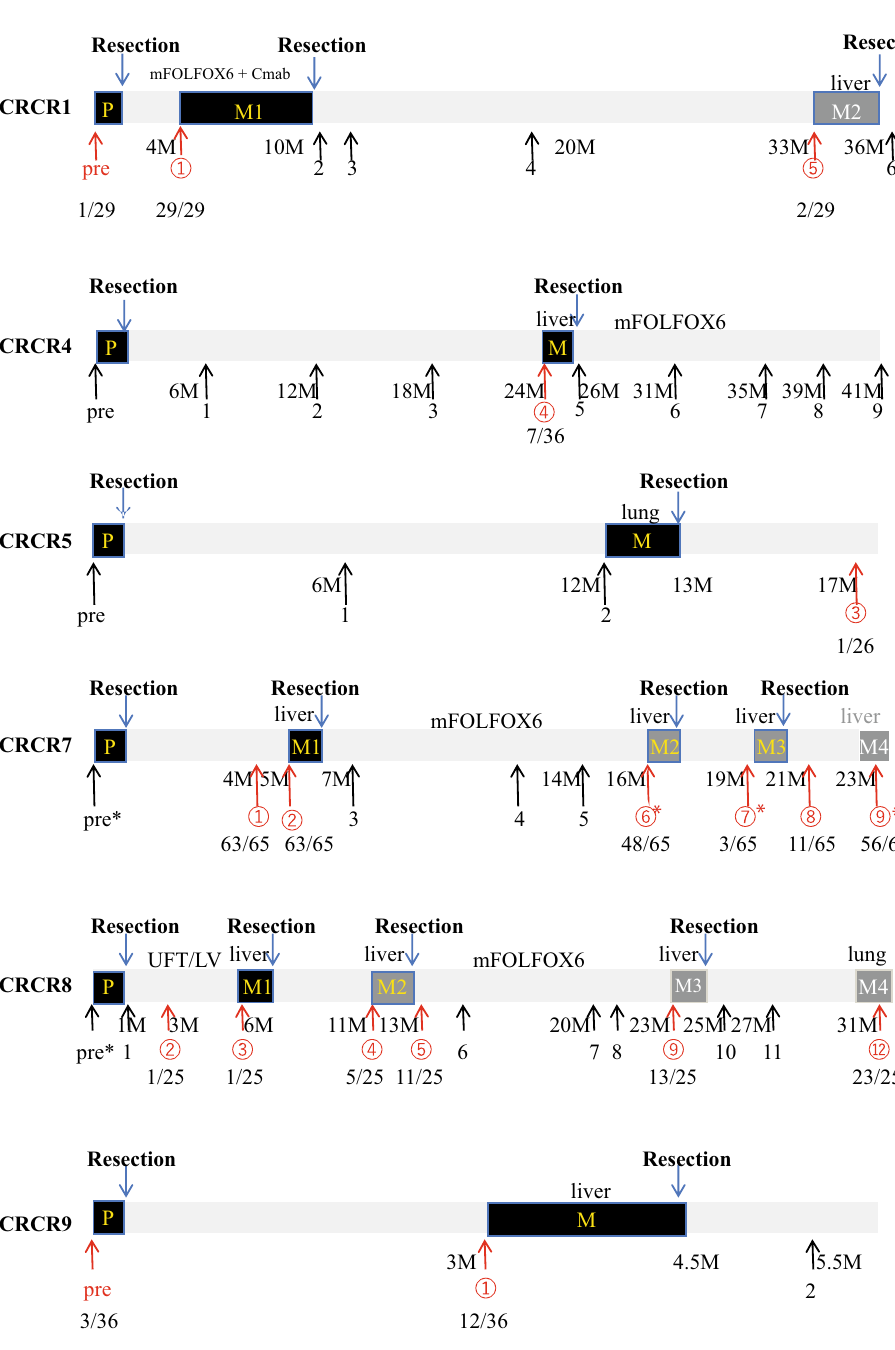
Figure 1. Plasma sampling from six cases of CRC with postoperative recurrence. Whole-exome sequencing and RNA sequencing of P (primary tumor) and M (metastatic tumor) were conducted. The number of mutated genes on each panel: CRCR1, 29; CRCR4, 36; CRCR5, 26; CRCR7, 65; CRCR8, 25; and CRCR9, 36. Numbers in the red circle indicate positivity for mutated genes in the ctDNA. We included the ratio of mutated genes to all genes in each cancer panel. Pre, preoperative plasma